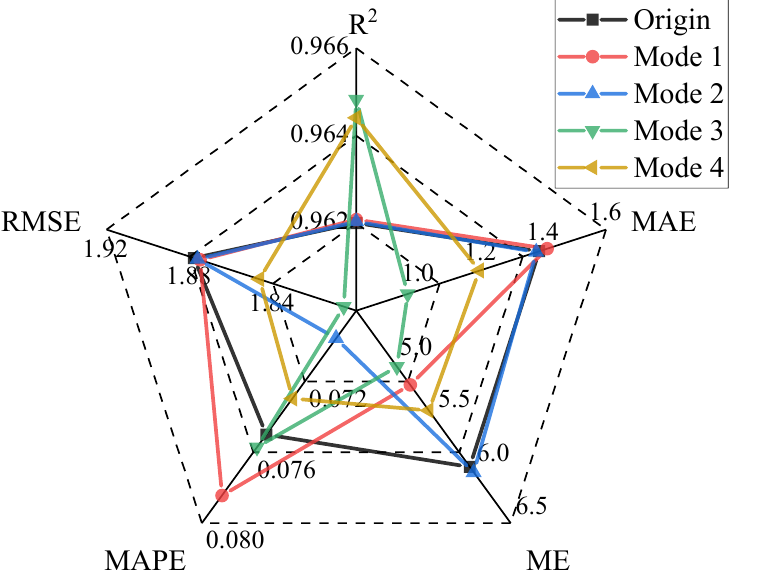
Figure 14. Comparison of performance indicators of the proposed model in four noise modes.